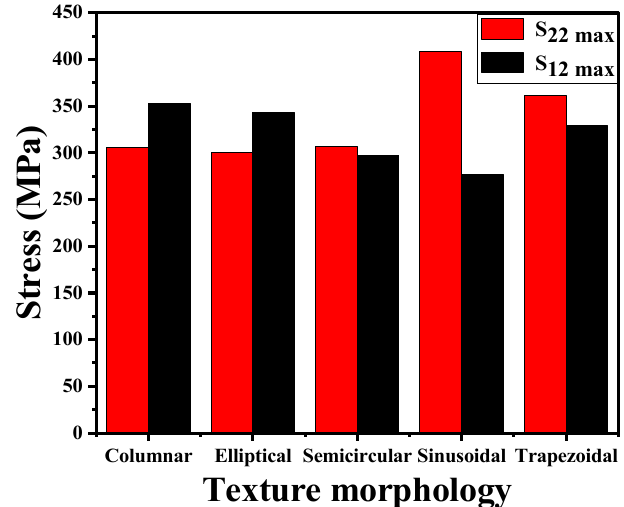
Figure 7. Maximum stress s 22 and s 12 of coatings after one thermal cycling. A periodic texture was extracted in order to better analyze the stress field distribution in the TC and BC layers. These five textures all share the same morphological characteris- tics as described in Section 2.2, so we use the elliptical texture as an example to discuss. stress along the edge, while the platform and two cusps bear tensile stress. The maximum